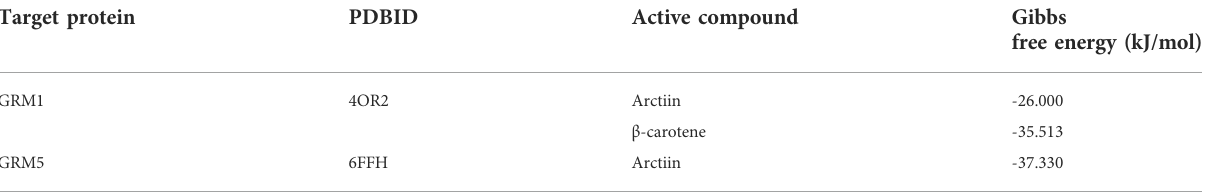
TABLE 2 Gibbs free energy of arctiin and β -carotene with GRM1 and GRM5. Target